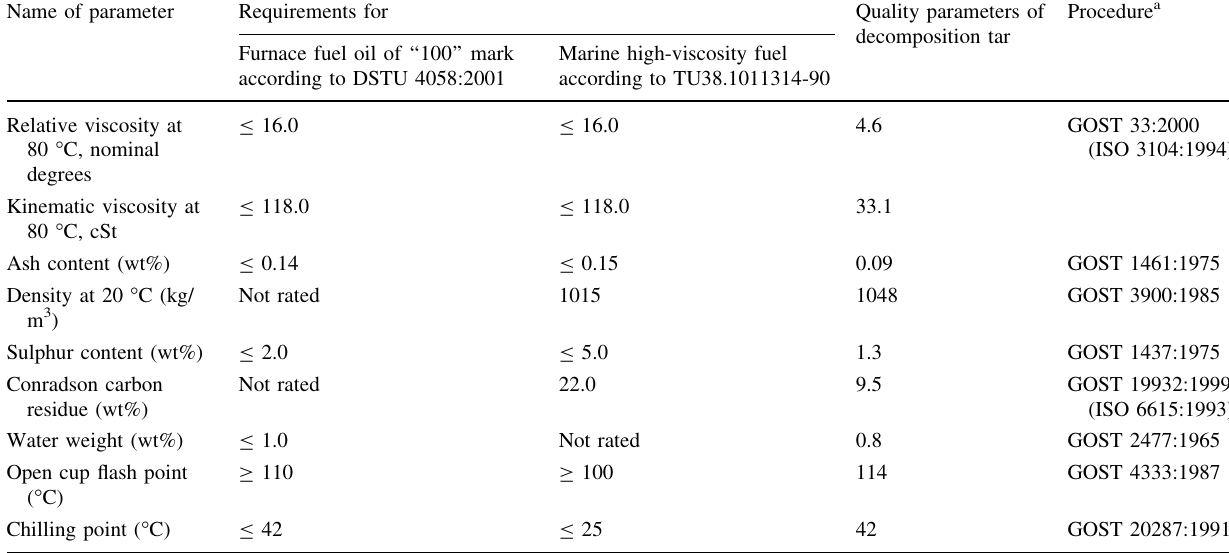
Table 9 Comparison between the quality parameters of lignite tar with the requirements for furnace fuel oil of ‘‘100’’ mark and marine high viscosity fuel Name of